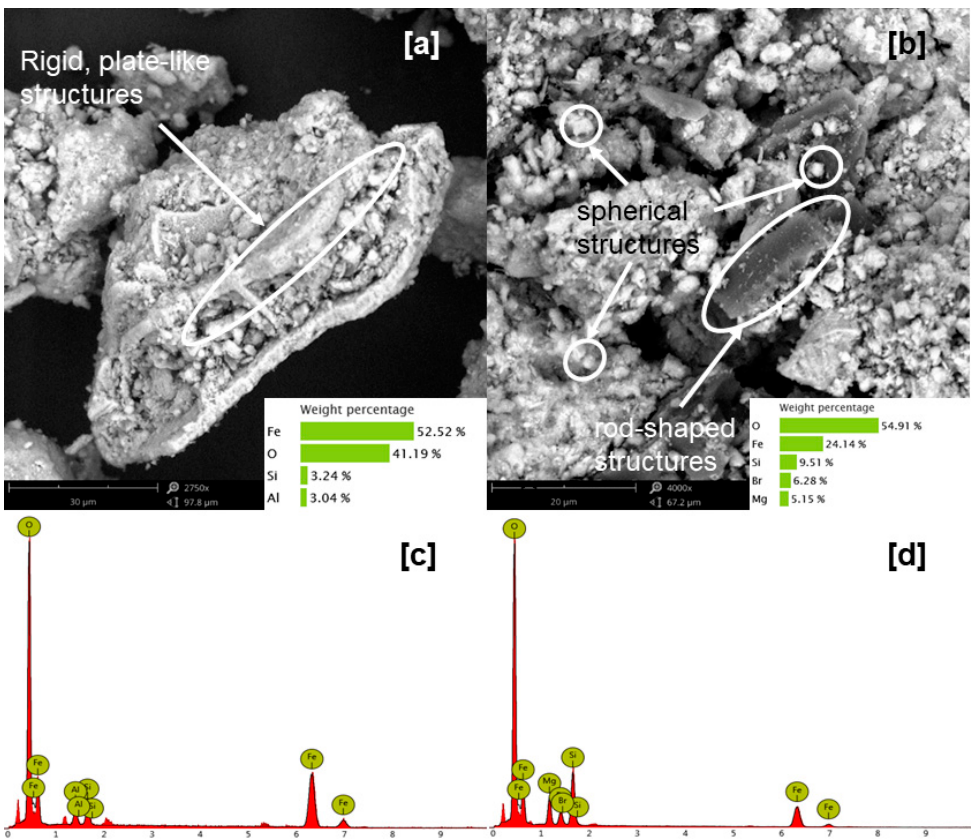
Figure 4. SEM-EDX images ( a ) Al-rich component and ( b ) Mg-rich component of the mixed dump sample and their respective spectra ( c and d ).